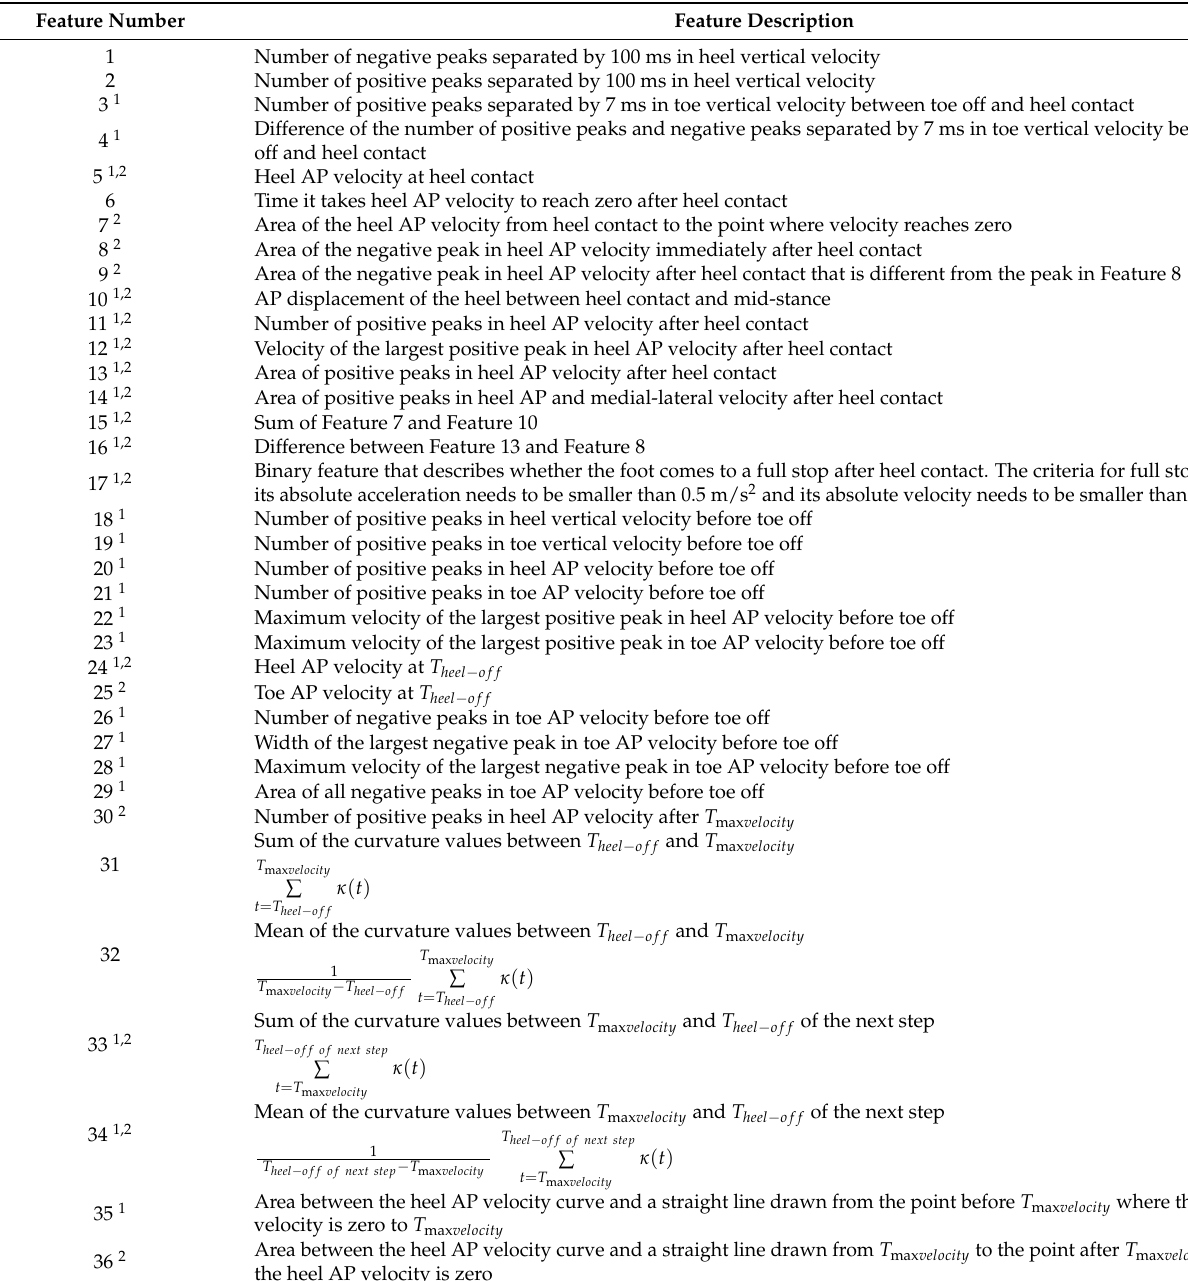
Table 3. List of features for each